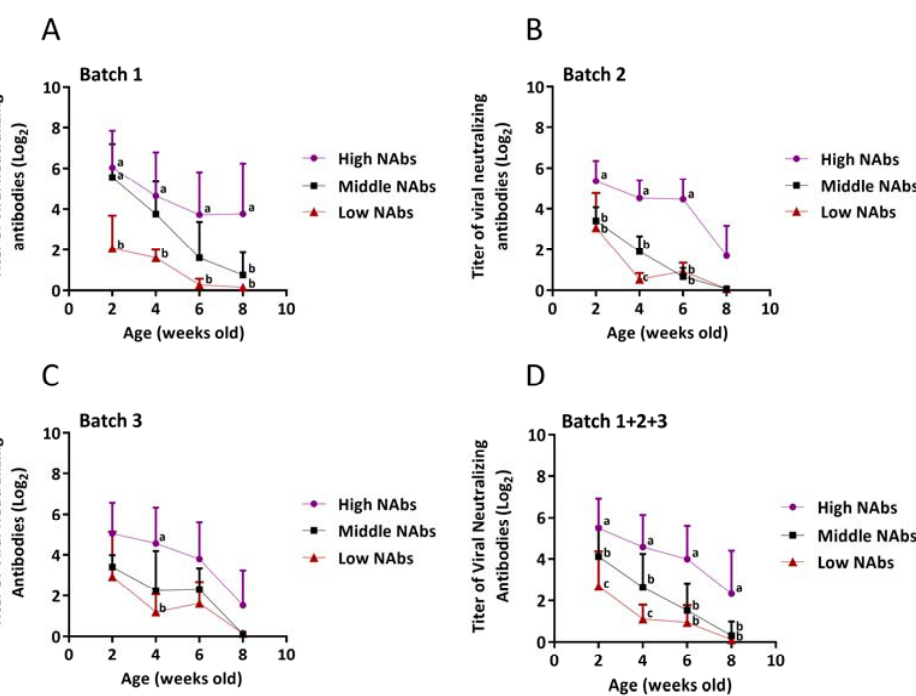
Figure 4. The mean titers of viral neutralizing antibodies (NAbs) in each group at 2, 4, 6, and 8 weeks of age ( A – D ). Error bars indicate standard deviations. ( A ) Titers of NAbs at each week of age between high and low NAbs were as listed below, 6.04 ± 1.61 log 2 and 2.06 ± 1.30 log 2 , 4.64 ± 1.91 log 2 and 1.60 ± 0.32 log 2 , 3.72 ± 1.86 log 2 and 0.26 ± 0.25 log 2 , and 3.76 ± 2.21 log 2 and 0.15 ± 0.10 log 2 . ( B ) NAbs titers at 2, 4, 6 weeks of age between high and low NAbs were as follows: 5.36 ± 0.89 log 2 and 3.06 ± 1.38 log 2 , 4.52 ± 0.78 log 2 and 0.53 ± 0.25 log 2 , and 4.47 ± 0.86 log 2 and 0.93 ± 0.34 log 2 . ( C ) Titers of NAbs at four weeks of age between high and low NAbs were 4.56 ± 1.58 log 2 and 1.20 ± 0.71 log 2 . ( D ) Viral NAbs titers at each week of age between high and low NAbs were reported, 5.48 ± 1.38 log 2 and 2.69 ± 1.57 log 2 , 4.57 ± 1.50 log 2 and 1.11 ± 0.64 log 2 , 4.00 ± 1.54 log 2 and 0.94 ± 0.78 log 2 , and 2.32 ± 2.01 log 2 and 0.12 ± 0.11 log 2. Statistically significant differences were recorded as a, b, and c ( p < 0.05).